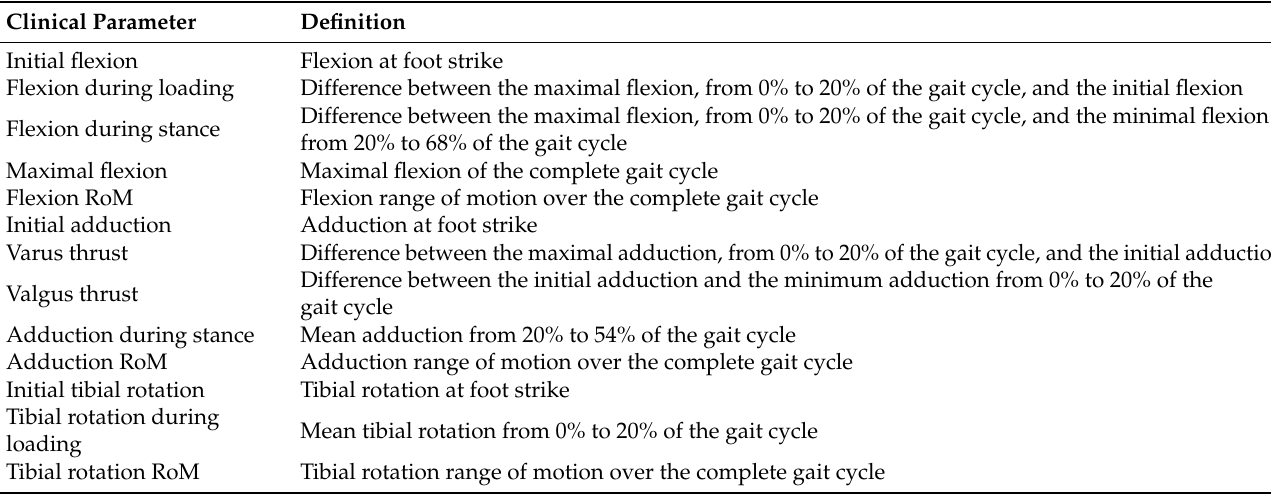
Table 1. Definitions of the calculation of the clinical parameters.